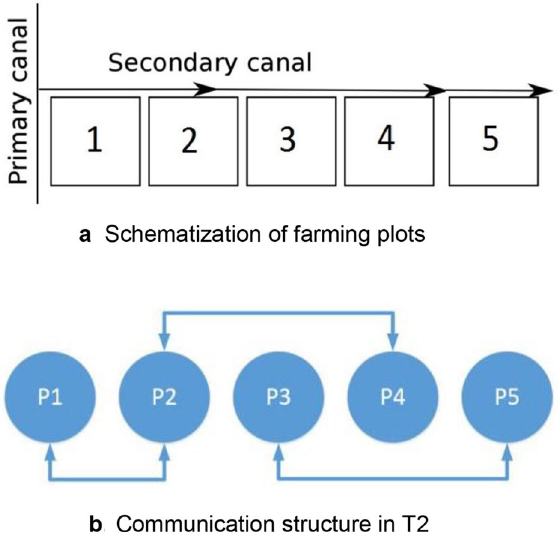
Figure 1. Schematization of farming plots and communication structure in T2.